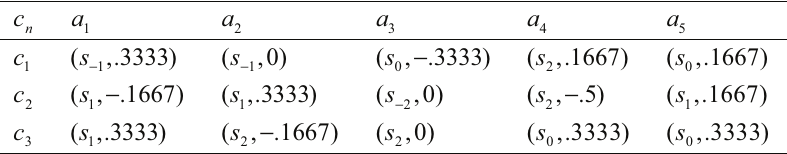
G after second 1